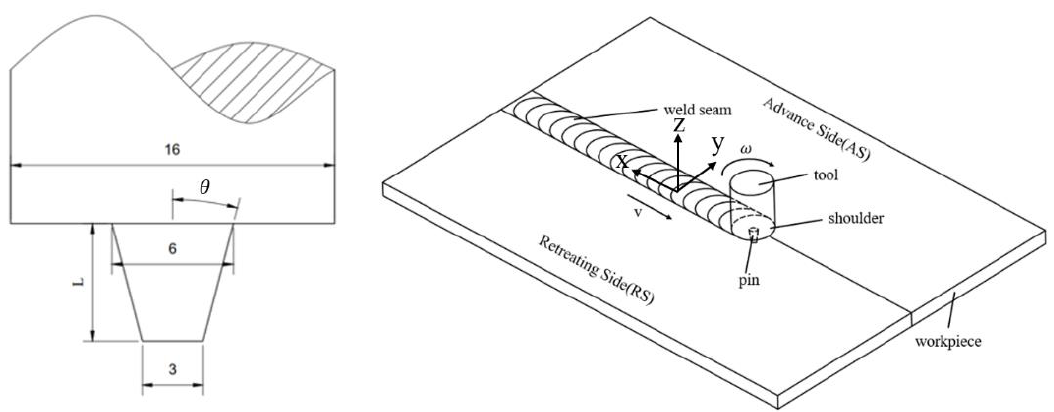
Figure 1. Schematic diagram of tool size and welding sample.